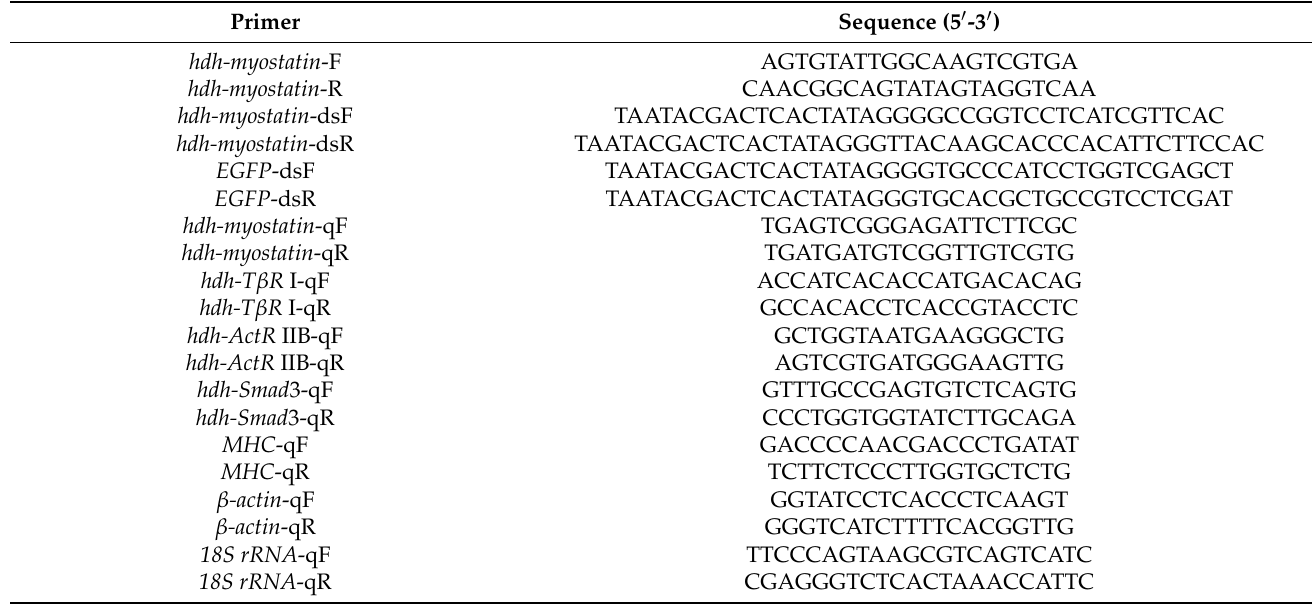
Table 1. Sequences of the primer pairs used in this